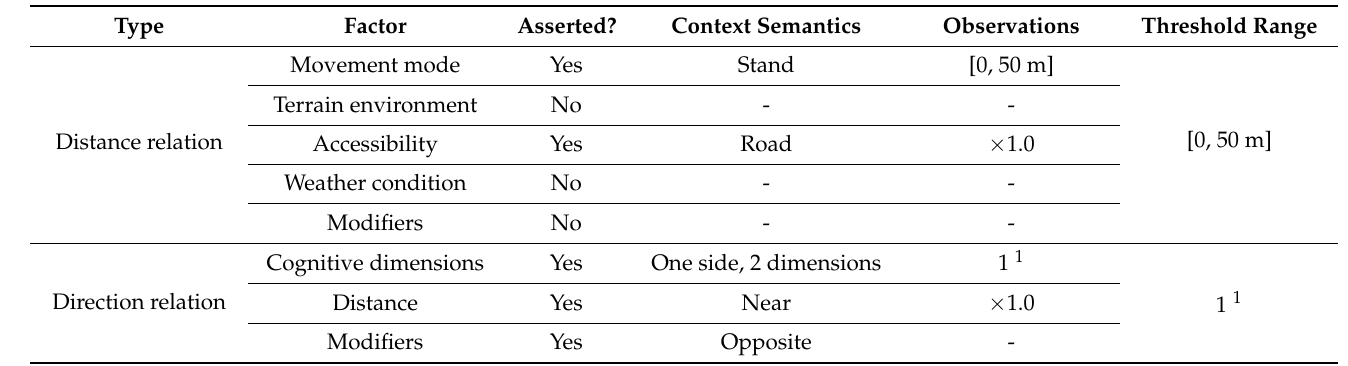
Table 4. Semantic analysis based on supervaluation of spatial assertion of Sunshine Commercial Building.